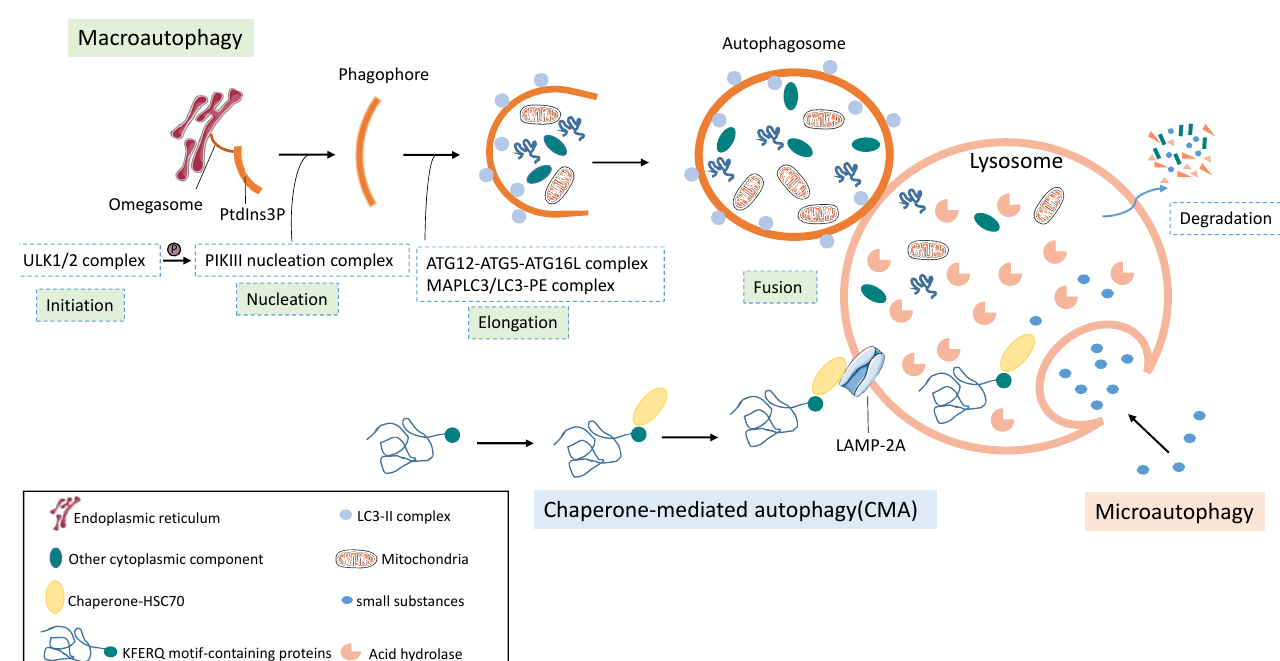
Figure 1. The process of autophagy. According to the type of cargo and delivery method, autophagy can be classified as macroautophagy, microautophagy, and chaperone-mediated autophagy (CMA). Macroautophagy is a process that autophagosome fuses with a lysosome to form an autolysosome, which mainly degrades dysfunctional or obsolete cytoplasmic components. Several complexes composed of autophagy-related proteins (ATG) act synergistically with membrane transport components resulting in the formation of autophagosome. CMA is a highly selective pathway, KFERQ motif-containing proteins recognized by Chaperone-HSC70 binds to LAMP-2A located in lysosome to be degraded. Small cytoplasmic substances are engulfed directly by the lysosome, called